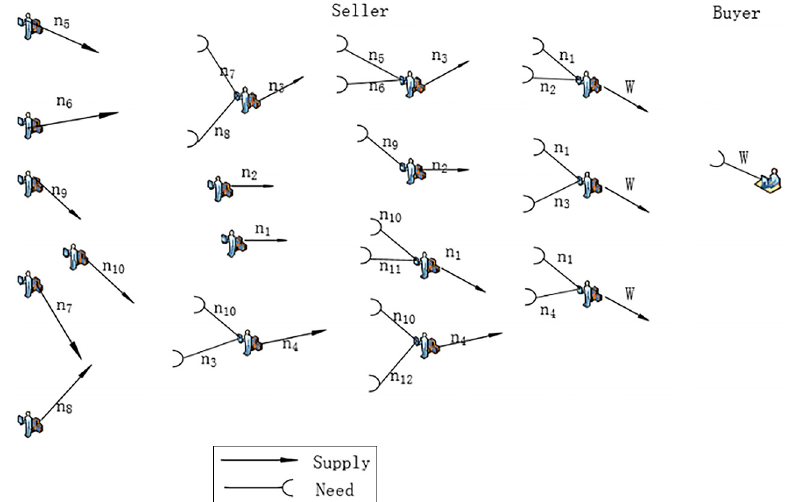
Figure 7. Supply and demand matching